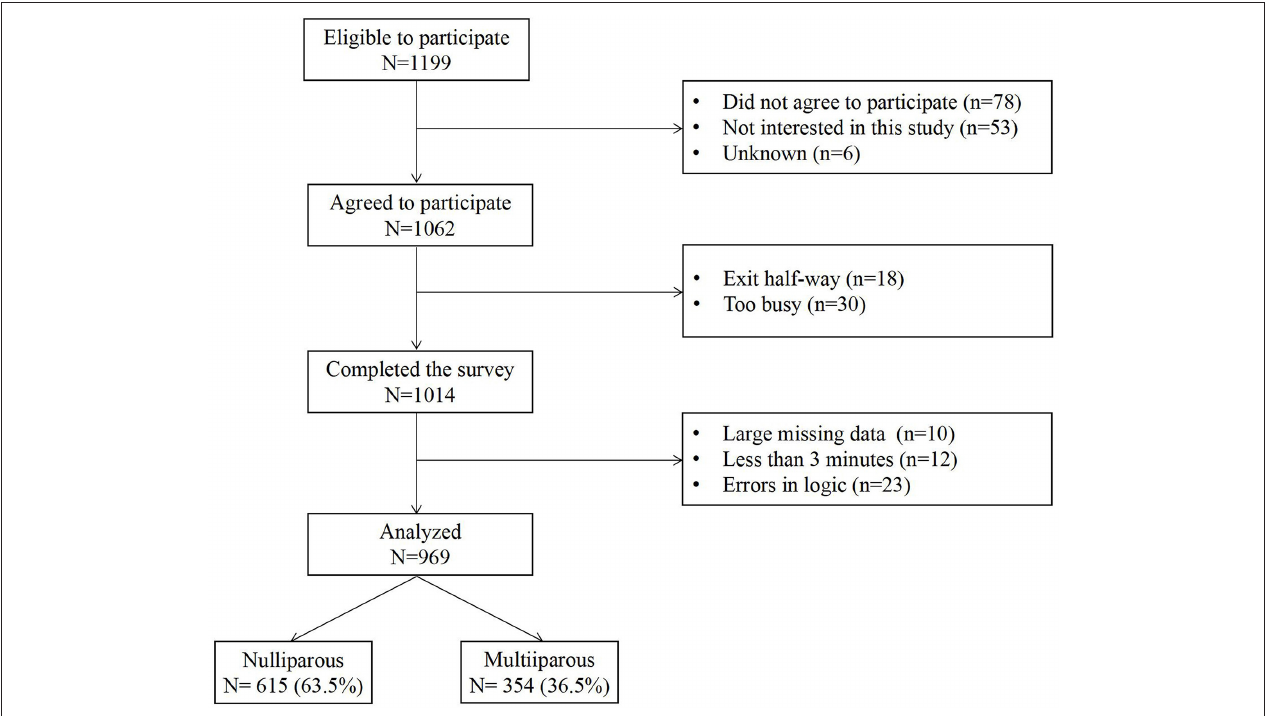
FIGURE 1 | A flow chart of the